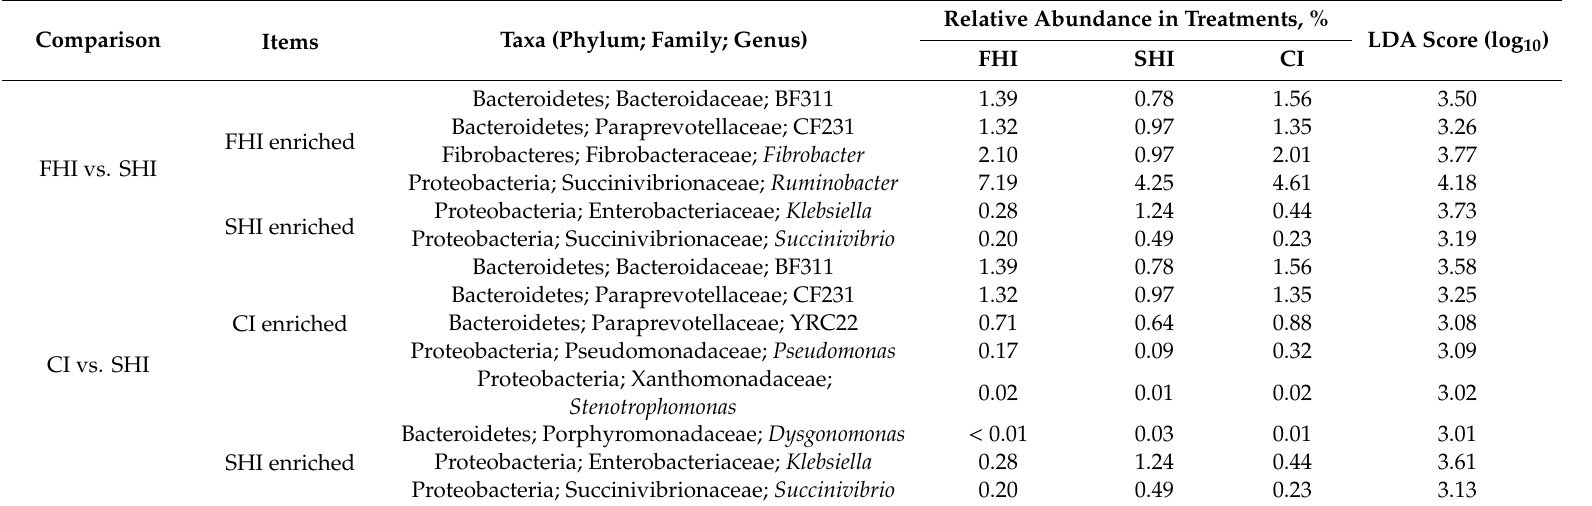
Table 2. The relative abundance (%) of significantly changed taxa between FHI and SHI and between CI and SHI.